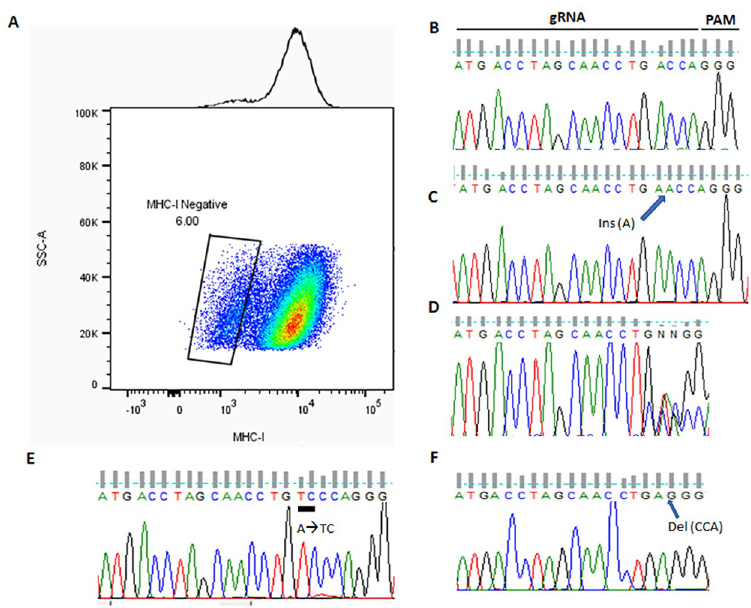
Fig 4. Enrichment of DKO s with FAME strategy in HEK293T cells co-targeted for B2M and PTEN. (A) HEK293T cells were transfected with expression plasmids for spCas9, and sgRNAs for B2M and PTEN . 5 days later, transfected cells were stained with FITC-conjugated antibody against human HLA-A,B&C. Single isolated cells with positive and negative surface MHC-I were sorted into 96-well plates. B-F. After expansion of the isolated clones, the region targeted by sgRNA was PCR amplified from genomic DNA, and submitted for Sanger sequencing. Representative chromograms were shown in the context of the target site, including PAM (GGG), for the picked clones. B, a typical wild type colony from MHC-I positive population identified with PCR sequencing; C, a typical DKO colony from MHC-I negative population with homozygous insertions identified with PCR sequencing; D, a colony (#4) from MHC-I negative population with illegible chromatogram with mixed signals; E and F, Sanger sequencing of plasmids with cloned PCR products from the same MHC-I negative colony as in D (#4) identified the exact mutations in each